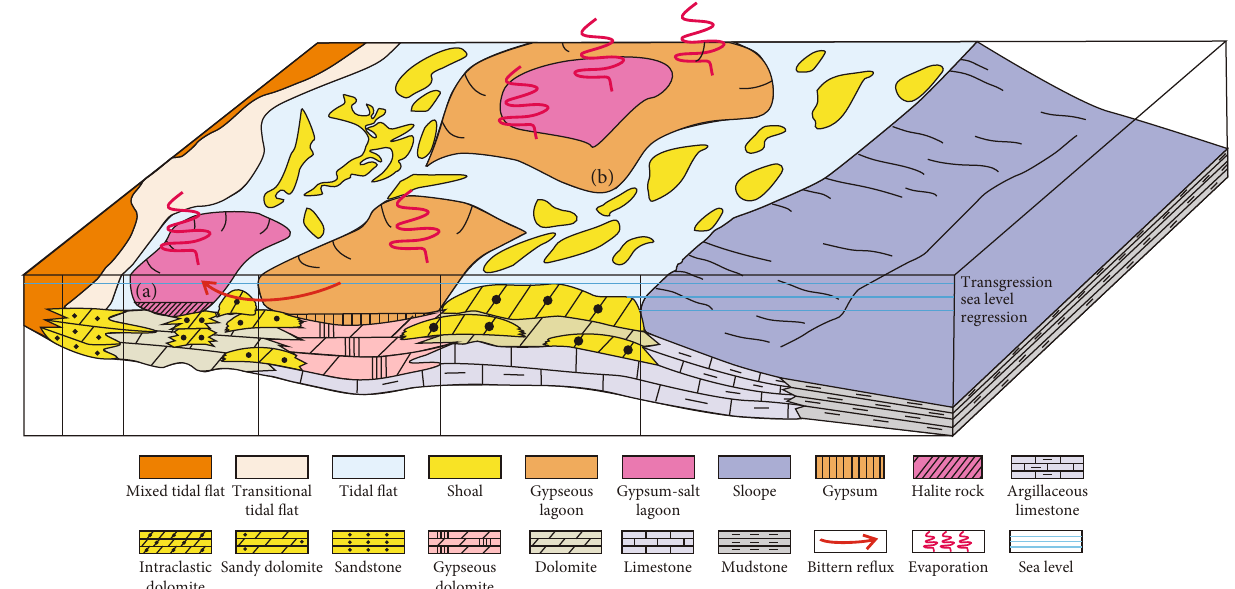
Figure 9: Genetic model of the Cambrian evaporite back fl ow in the Sichuan